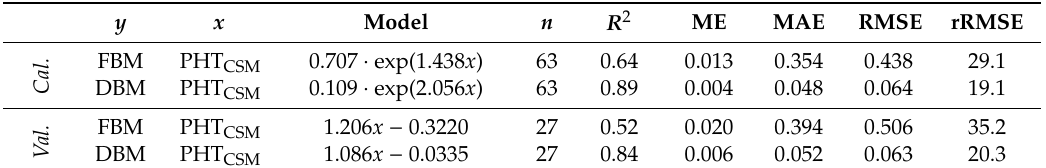
Table 4. Cross-validation results between fresh/dry biomass and PHT CSM for all missions. x = dependent variable; y = independent variable; ME = mean error; MAE = mean absolute error; RMSE = root mean square error; rRMSE = relative RMSE; p < 0.001 for all R² .